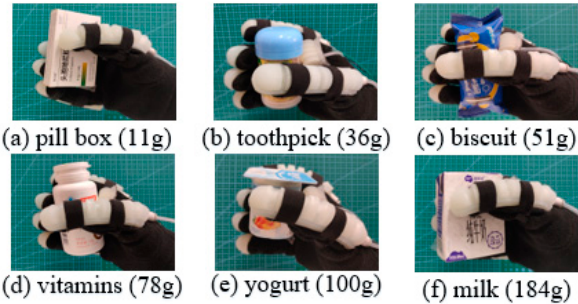
Figure 24. Grasping experiment. Figure 24. Grasping